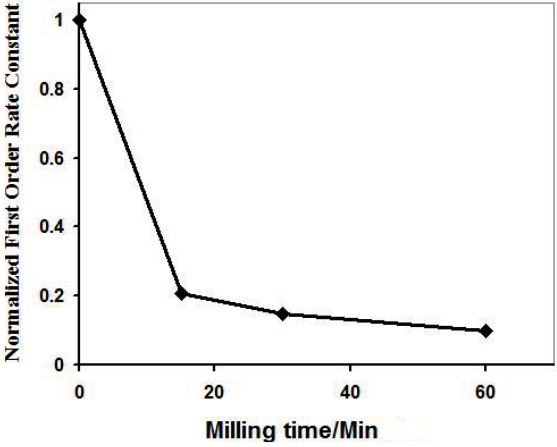
Figure 15. The effect increasing milling times on the first order rate constant for the degradation by high area rutile of 0.36 mM salicylic acid at pH 4. Reprinted from J. Photochem. Photobiol. A 2010 , 216 , 268–274 [40] with